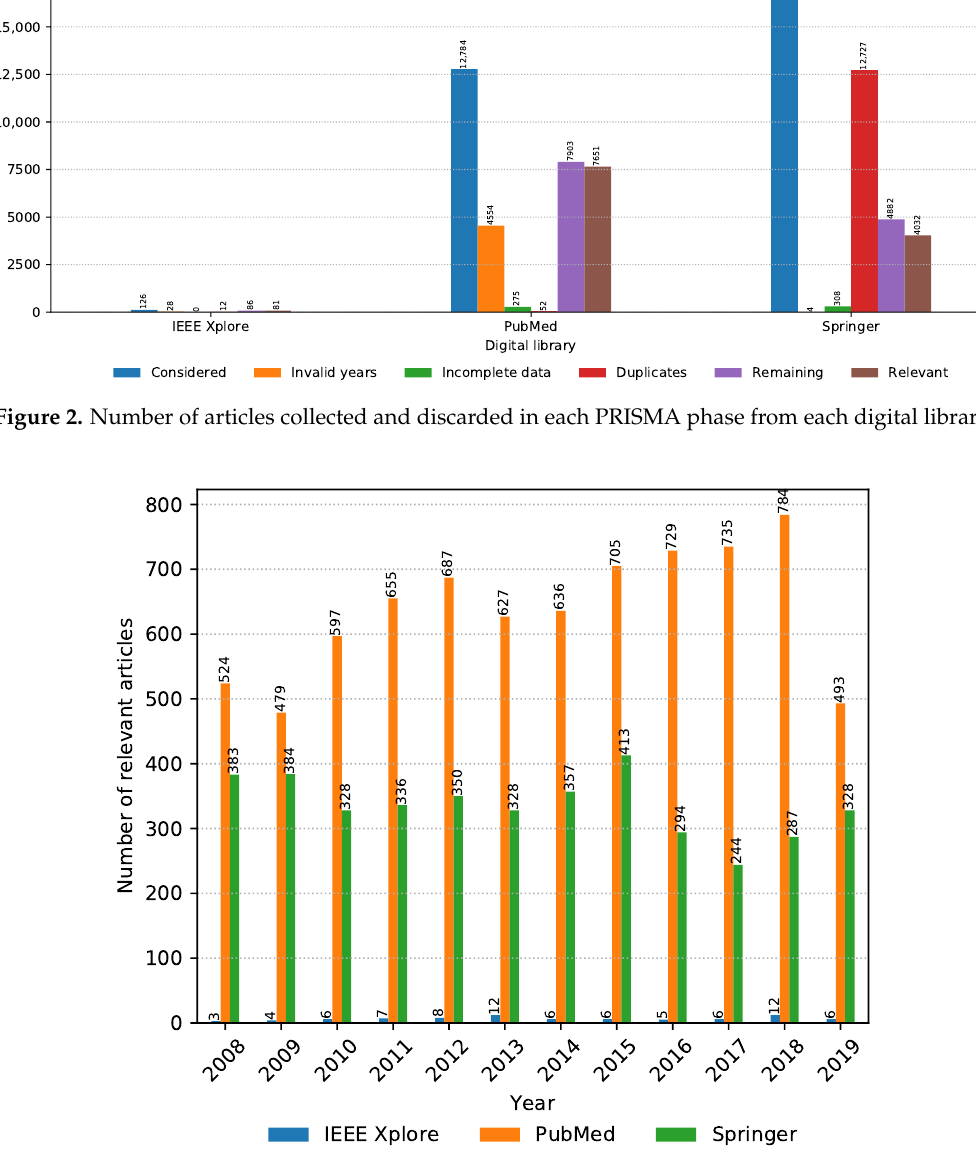
Figure 3. Number of relevant articles per year from 2008 to November 2019, aggregated by digital library